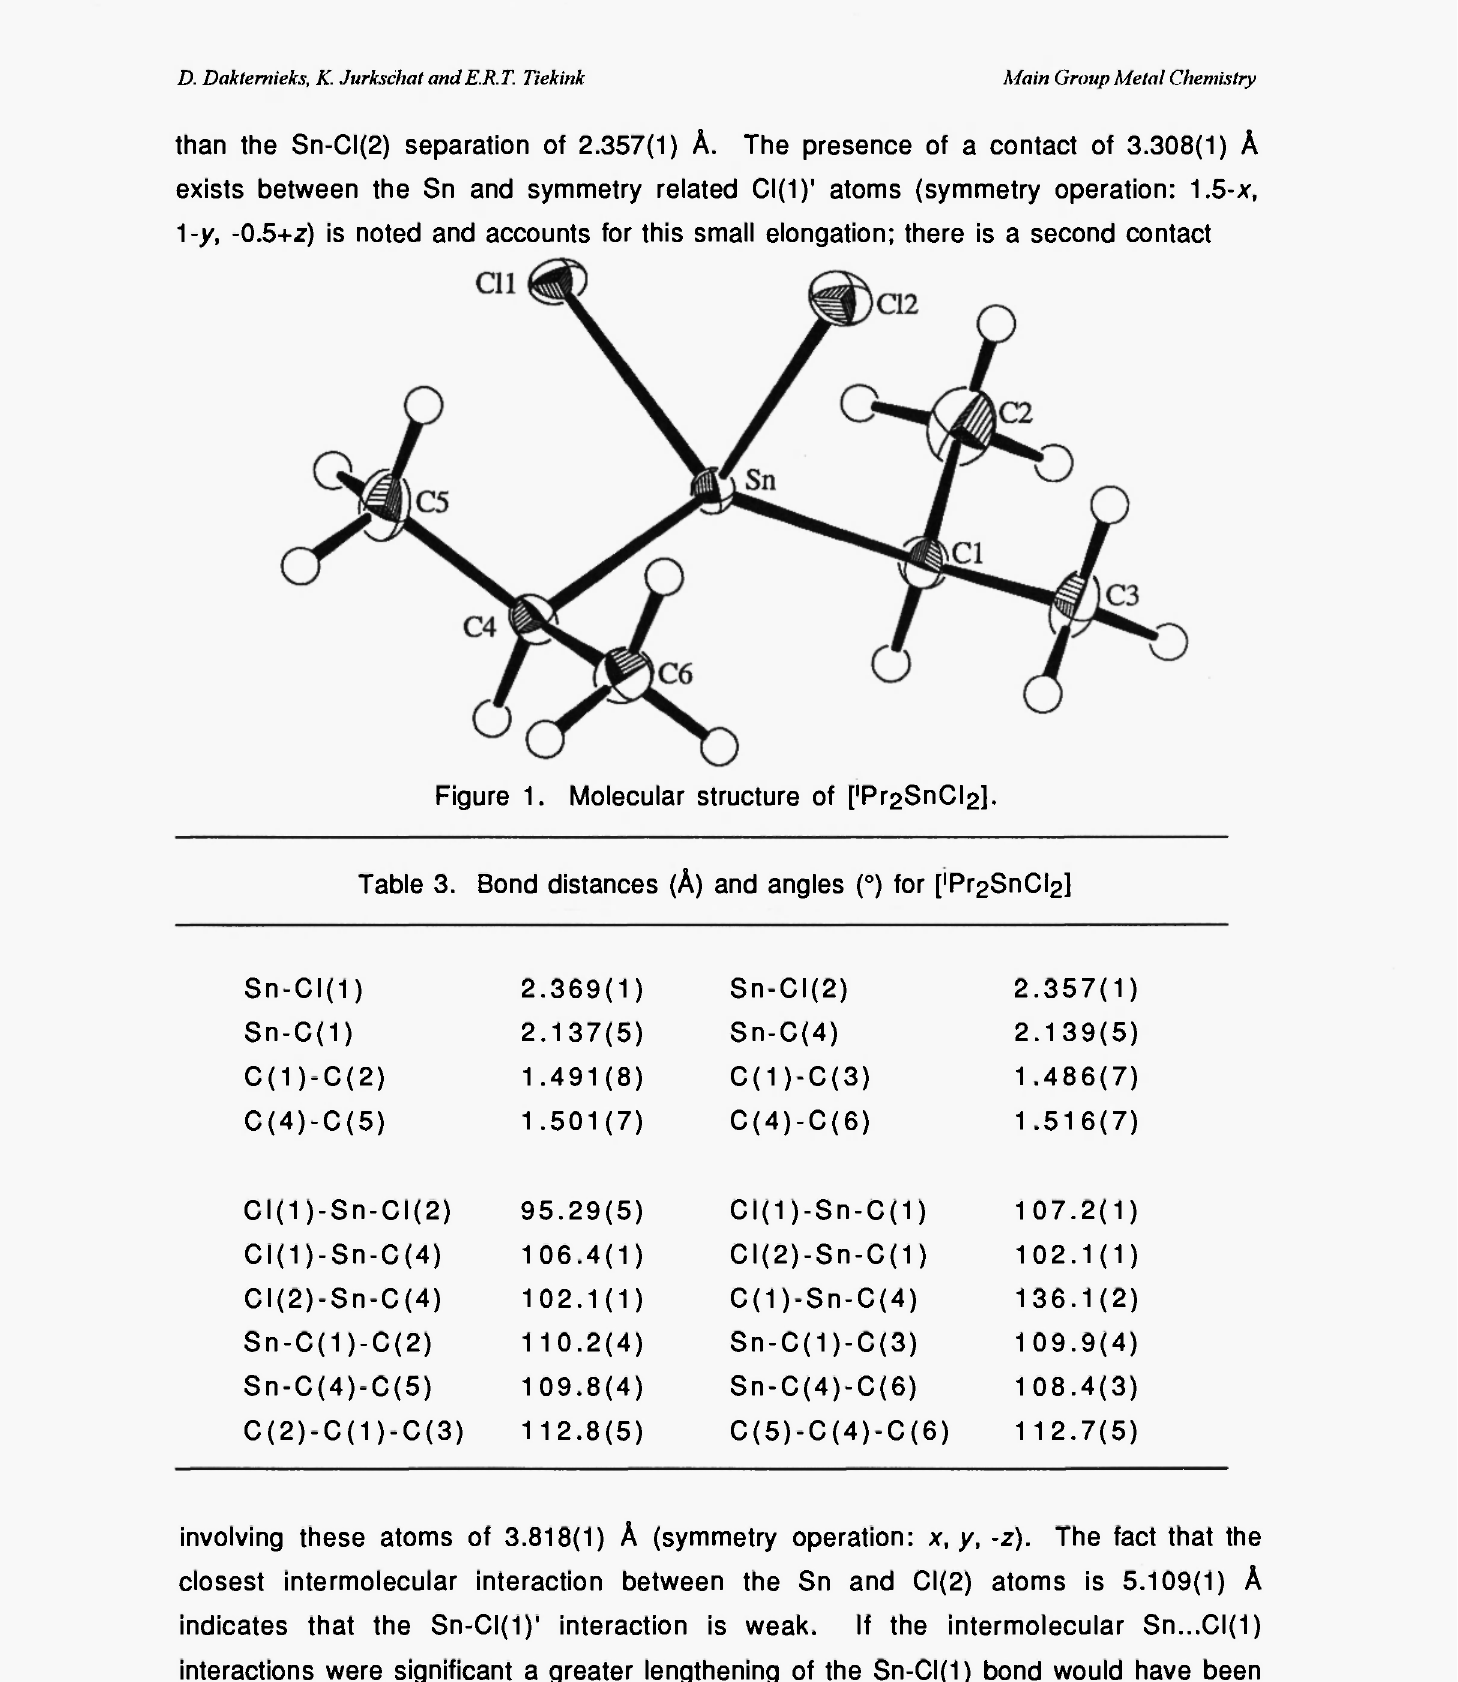
Table 3. Bond distances (A) and angles (°) for